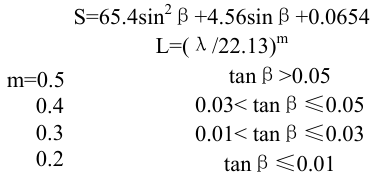
Figure 3. Relics used for elevation sampling. Archaeological dating shows these relics are from early Han dynasty (~4 A.D.)